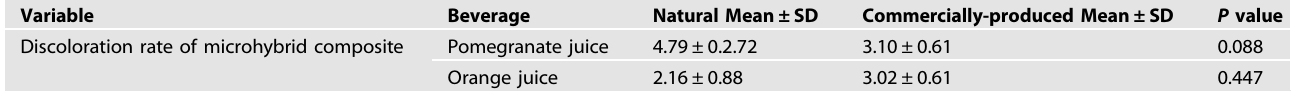
Table 1. Comparing discoloration rate of microhybrid composite exposed to natural and commercially-produced juices. Variable Beverage Discoloration rate of microhybrid composite SD standard